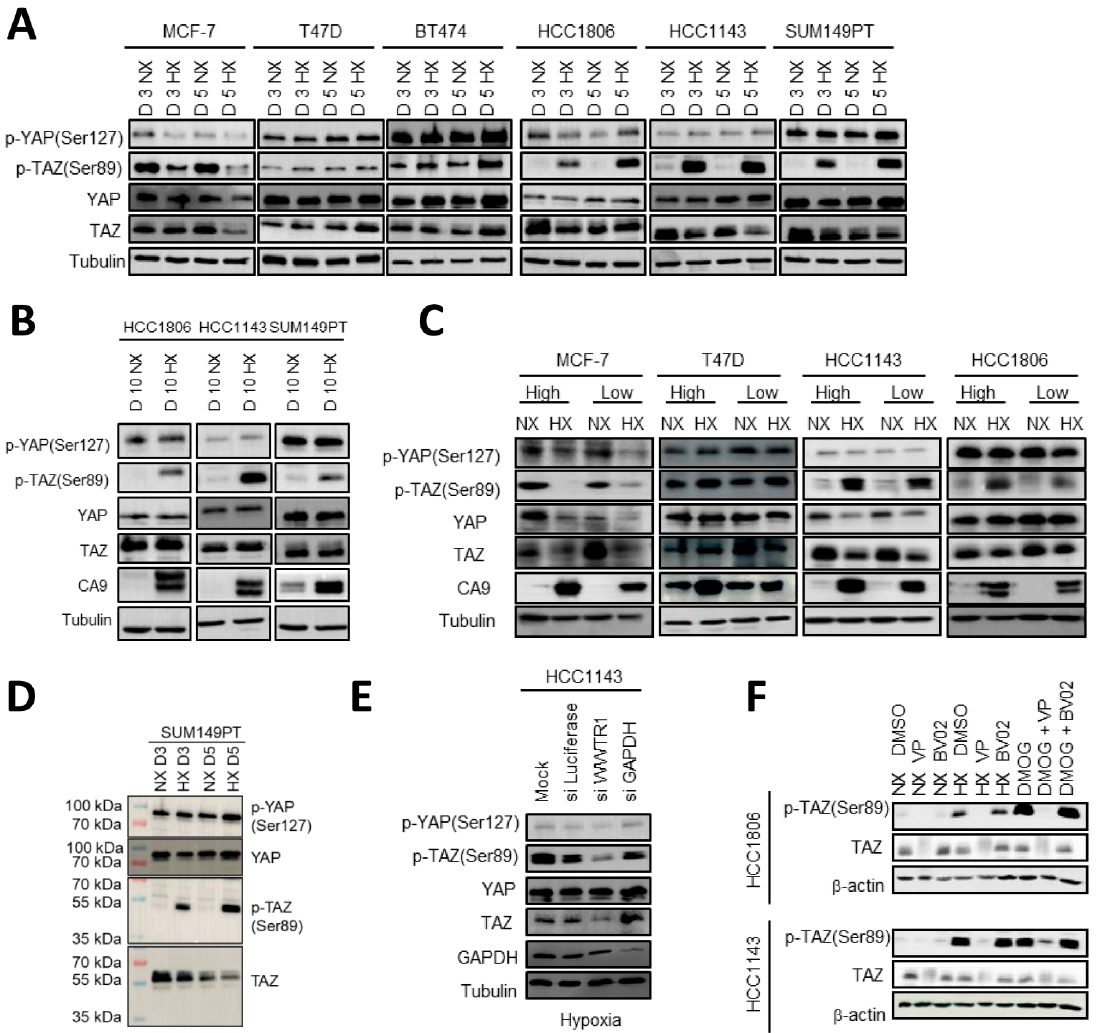
Figure 4. HIF1-mediated phosphorylation of TAZ at Ser89 under hypoxia in basal A but not luminal breast cancer cells. ( A , B ) Western blot showing YAP, TAZ, p-YAP (Ser127) and p-TAZ (Ser89) for three luminal (MCF7, T47D and BT474) and three basal A (SUM149PT, HCC1806 and HCC1143) breast cancer cell lines incubated under normoxia (NX) or hypoxia (HX) for 3 or 5 ( A ) or 10 days ( B ). Tubulin serves as loading control. ( C ) Western blot showing the indicated (phospho- )proteins for the indicated luminal and basal A cells seeded at low density (6 × 10 4 cells/petri dish; subconfluent) or high density (15 e 4 cells/petri dish; confluent) and exposed for 5 days to normoxia or hypoxia. ( D ) Western blot analysis of the indicated (phospho-)proteins for SUM149PT exposed for 3 or 5 days to normoxia or hypoxia. ( E ) Western blot analysis of the indicated (phospho-)proteins for HCC1143 cells treated with TAZ (WWTR1) SMARTpool siRNAs or the indicated control SMARTpool siRNAs and exposed for 5 days to hypoxia. ( F ) Western blot showing p-TAZ (Ser89) and TAZ in HCC1806 and HCC1143 cells cultured in absence or presence of Verteporfin (5 µM) or BV02 (5 µM) while exposed to normoxia, hypoxia, or DMOG (1 mM) for 3 days. β -actin serves as loading control.